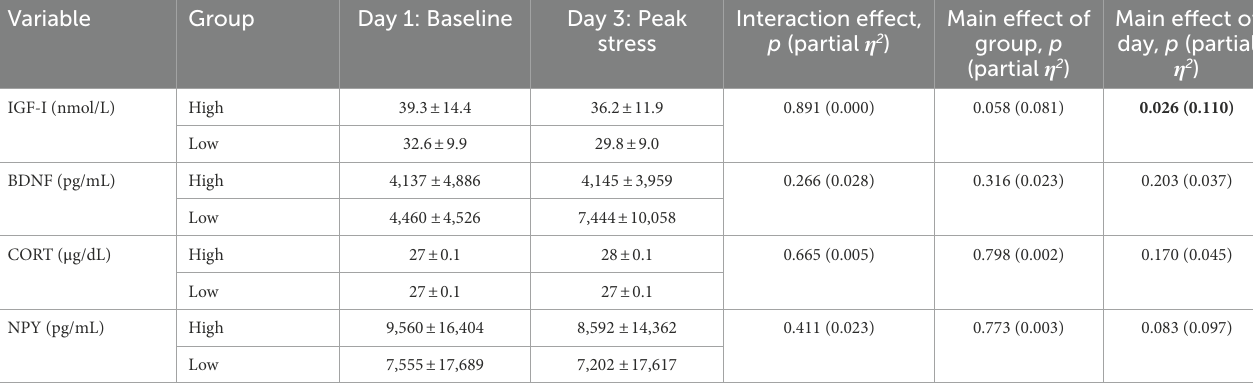
1 Raw data shown for reader clarity. Data presented as mean ± SD across baseline and peak stress and presented as p (partial η 2 ) for group comparisons. Significance was set at p < 0.05. NPY, neuropeptide-Y; CORT, cortisol; BDNF, Brain-derived neurotropic factor; IGF-I, Insulin-like growth factor-I. Bold denotes significant